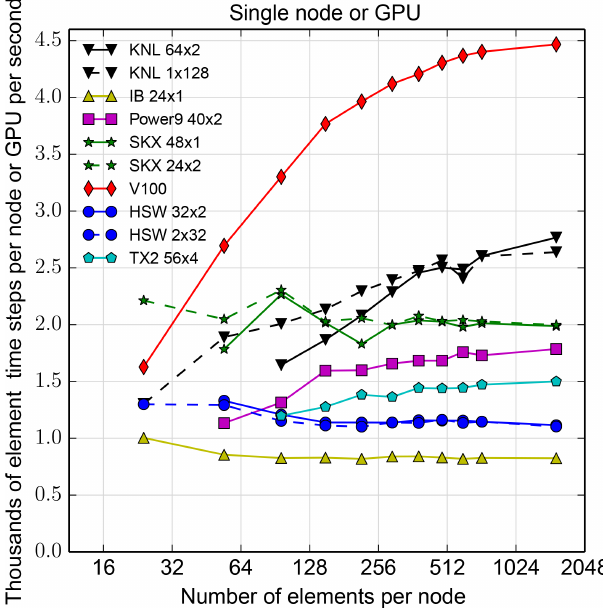
Figure 12. Single-node performance as a function of number of elements for several architectures, with various threading options. See caption of Fig. 11 for architecture names. Number of MPI ranks r and number of threads t in a configuration is denoted r × t . Data